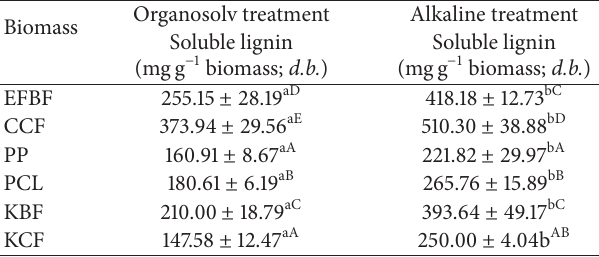
kenaf core fiber. (b)a-b:differentalphabetsinthesamerowrepresentthattherearesignificant differences between the mean values of the different treatments ( 𝑃 < 0.05 ). (c) A–E: different alphabets in the same column represent that there are significant differences between the mean values of the different biomasses ( 𝑃 < 0.05